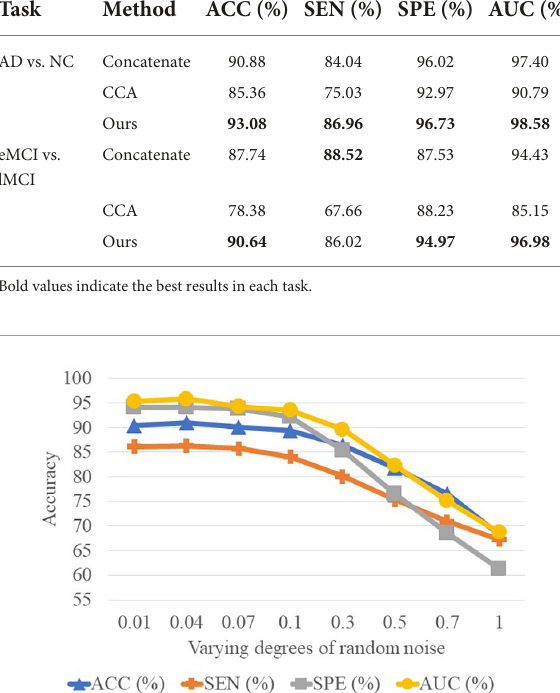
FIGURE8 Results achieved by the proposed method with varying degrees of functional brain network (FBN) random noise of Pearson’s correlation (PC) in lMCI vs. eMCI classification.